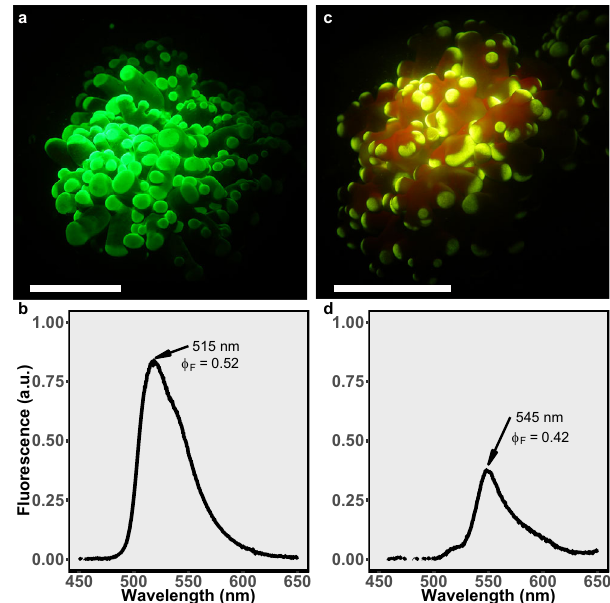
Fig. 5 Fluorescence morphs of the mesophotic coral Euphyllia paradivisa . a , c Fluorescent images and corresponding b , d fl uorescence emission spectra of a , b green and c , d yellow fl uorescence morphs of E. paradivisa . The relative coral fl uorescence emission peaks (515 nm for the green morph and 545 nm for the yellow morph) and fl uorescence ef fi ciency ( Φ F ) are indicated by arrows. Scale bars indicate 1 cm.